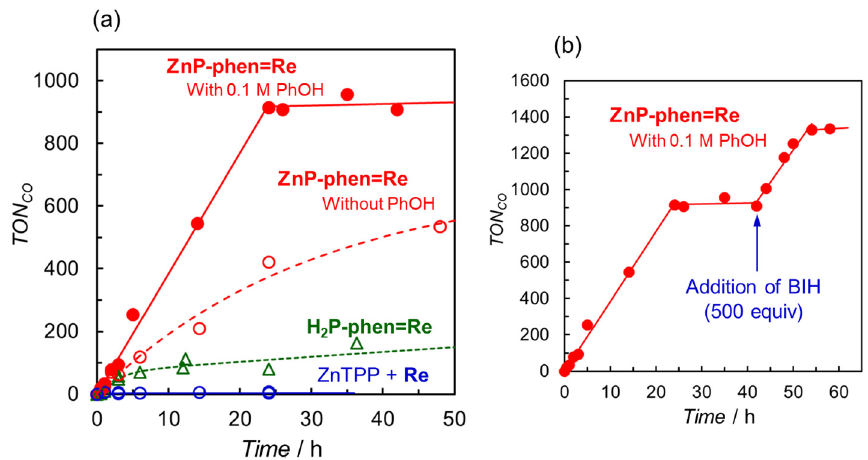
Figure 9. ( a ) Time dependences of CO formation during irradiation at 420 nm in CO 2 -saturated DMA solutions containing BIH (1000 equiv against the Re complex) in the presence of ZnP-phen=Re with (red filled circle) and without PhOH (red open circle), H 2 P-phen=Re (green open triangle), and a mixed system of ZnTPP and fac -Re(phen)(CO) 3 Br ( Re ) (blue open circle). ( b ) Further addition of BIH to ZnP-phen=Re after 42 h of irradiation in the presence of PhOH [43,44].